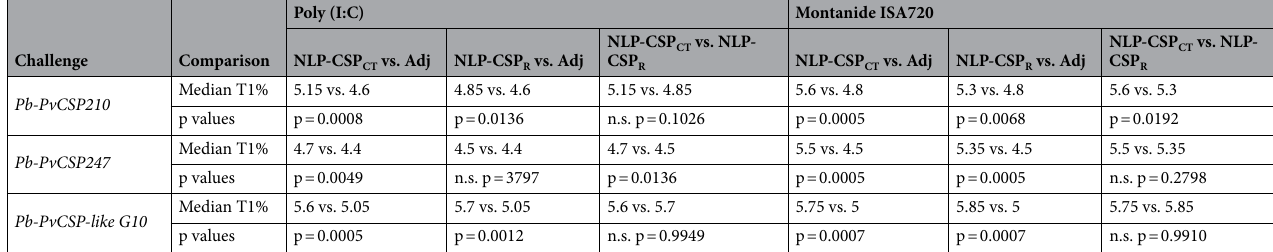
Table 2. Prepatent (T1%) periods and statistical significance of protective efficacy. Significant differences (p < 0.05) were analyzed by applying the log-rank (Mantel-Cox) test. n = 6 mice/group. n.s.: not significant